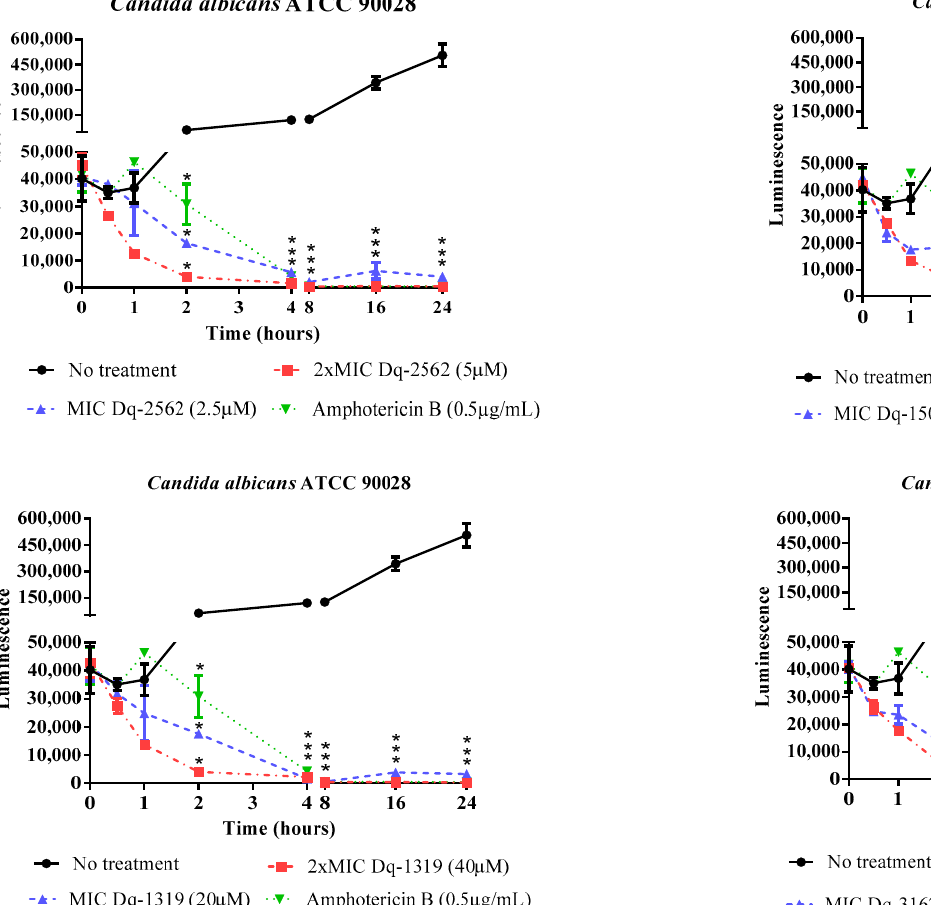
Figure 1. Effect of exposure time to synthetic pilosulin- (Dq-2562, Dq-1503, and Dq-1319) and ponericin-like (Dq-3162) peptides on the cell viability of Candida albicans ATCC 90028. ANOVA and Tukey’s multiple comparisons test. * p < 0.05 (compared to untreated Candida cells).